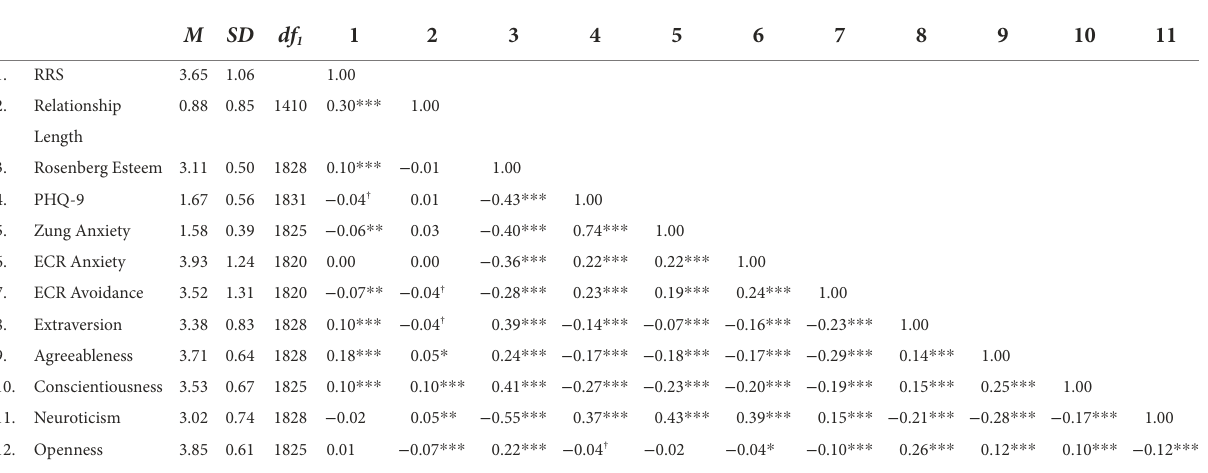
TABLE 5 Validity construct correlation